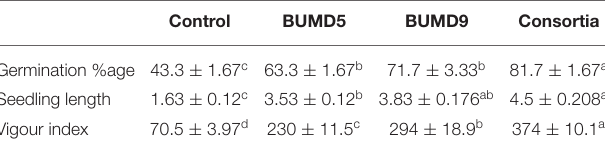
by open circles) as well as better rates of electron transport (indicated by the width of the blue line). T5 was found to be best with regard to the performance of the photosynthetic parameters.